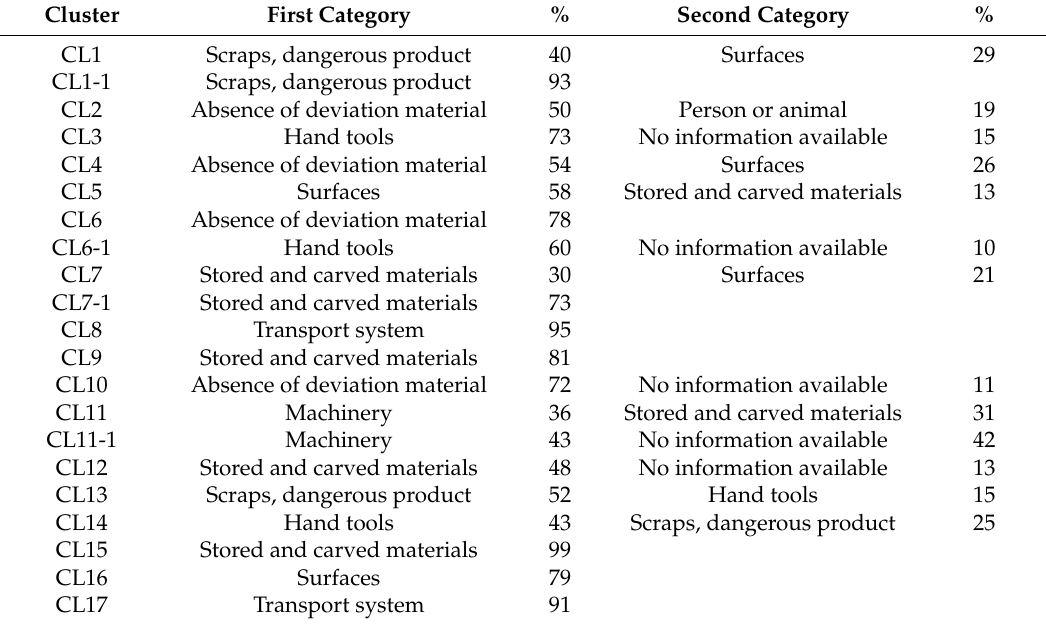
Table A4. Clusters description (Deviation material).